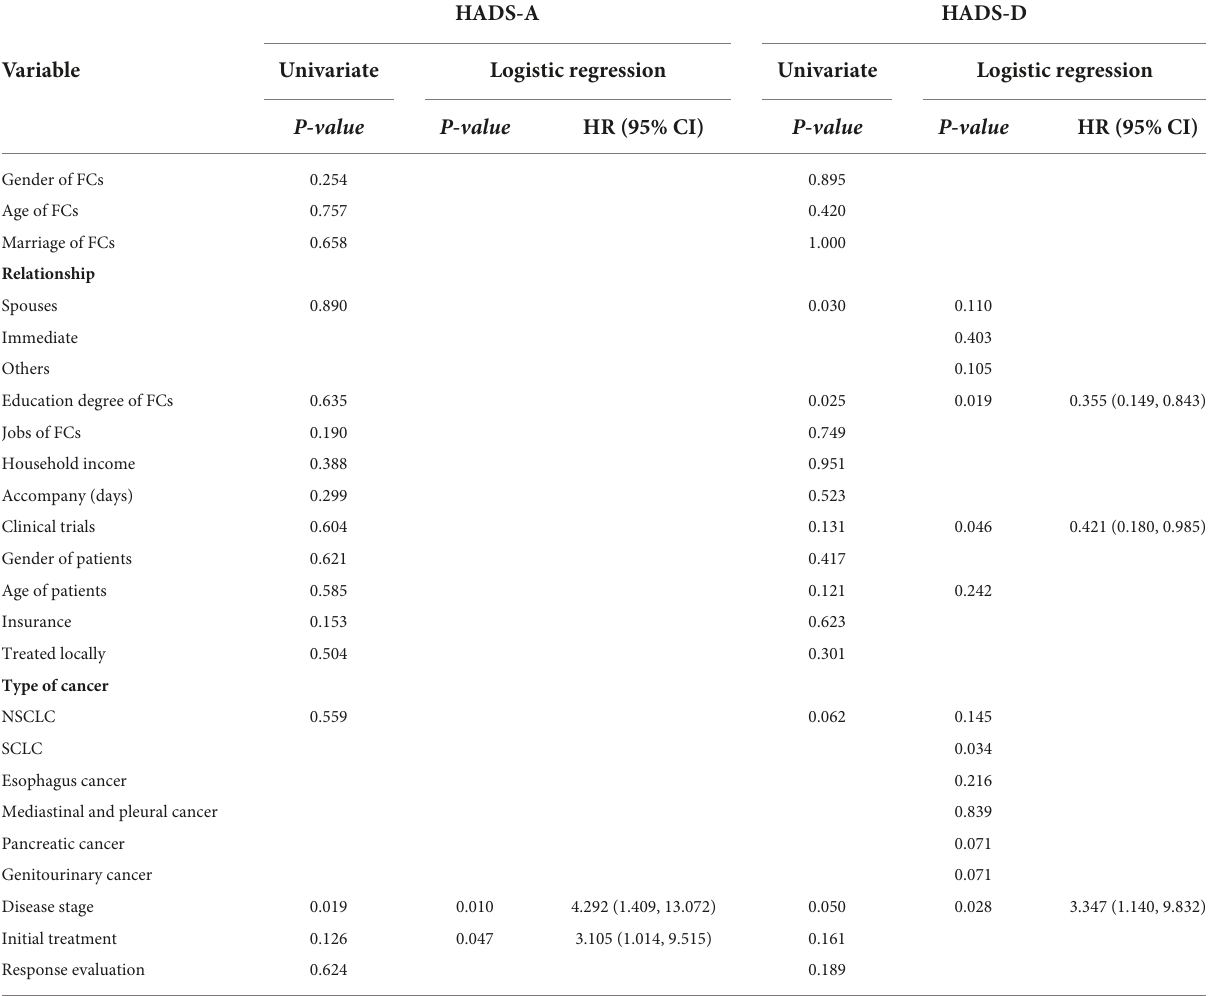
TABLE 2 Univariate and logistic regression analysis of anxiety and depression according to HADS. HADS-A HADS-D Univariate Logistic regression